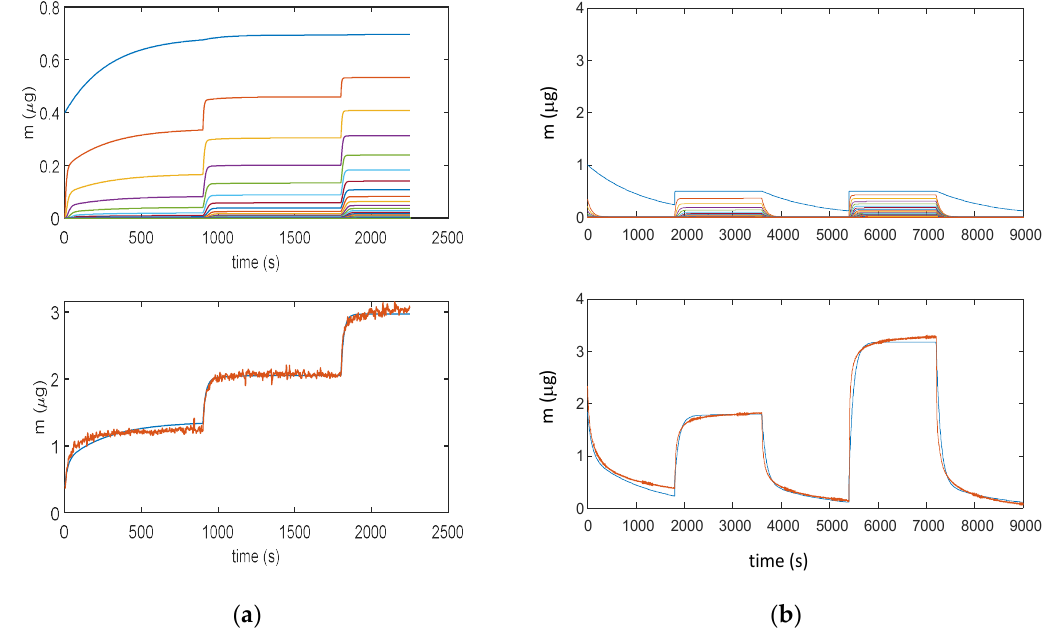
Figure 10. Results obtained with model in Equation (3): ( a ) Measurement protocol: starting from dry air, RH is increased with steps of 15% (RH = 15%, 30%, and 45%) each 15 min (900 s); ( b ) Measurement protocol: RH = 0% (30 min), RH = 25% (30 min), RH = 0% (30 min), RH = 50% (30 min), and RH = 0% (30 min). Lower plots for ( a ) and ( b ): total adsorbed mass; blue lines—adsorbed mass predicted by the model; and red lines—measured adsorbed water mass obtained exploiting the cantilever sensor (deposition of 35 µ g of TiO 2 nanoparticles). Upper plots for ( a ) and ( b ): mass adsorbed in the di ff erent layers predicted by the models; blue lines—first layer; other colors—upper layers.